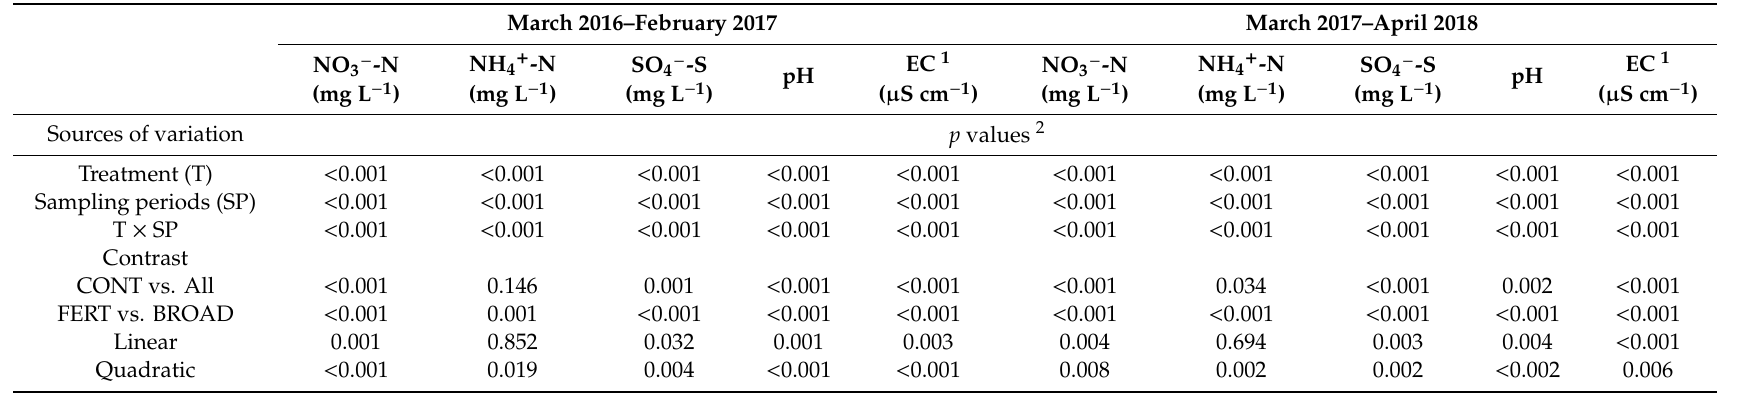
Table 1. Results of ANOVA for chemical properties of leachate water collected in lysimeters (30 cm depth) in the long-term blueberry experiment during the